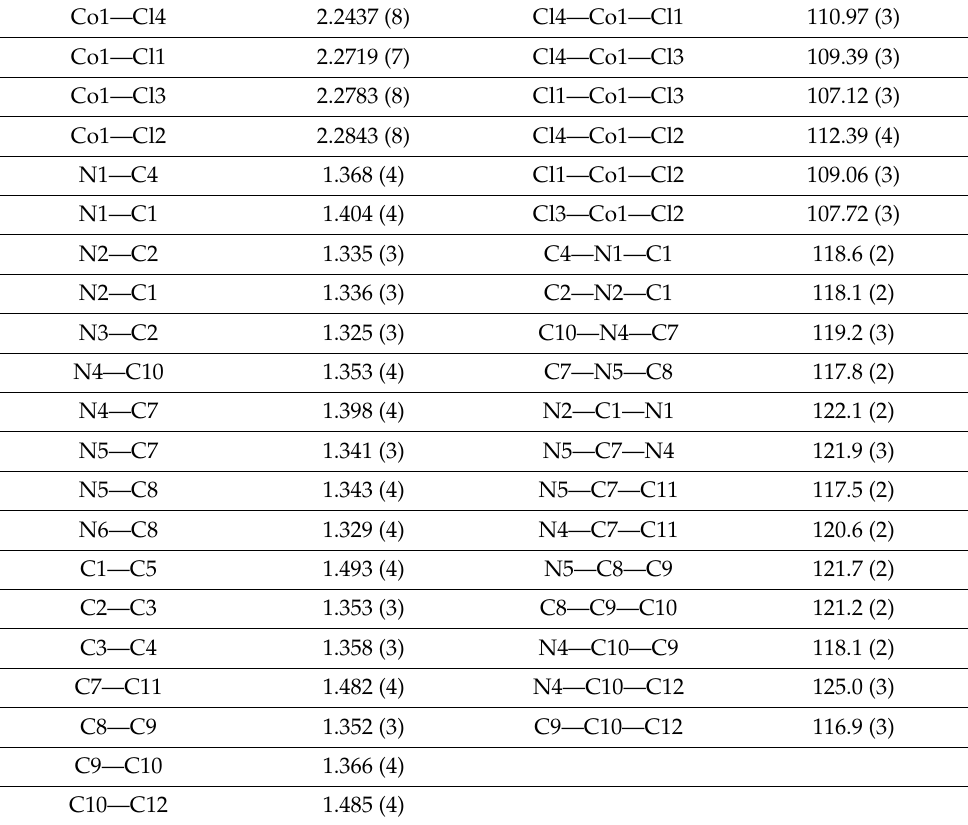
Figure 4. ORTEP of the structure of ( 2 ) with displacement ellipsoids drawn at the 50% probability level. Table 4. Selected bond distances and angles (Å, ◦ ) in complex ( 2